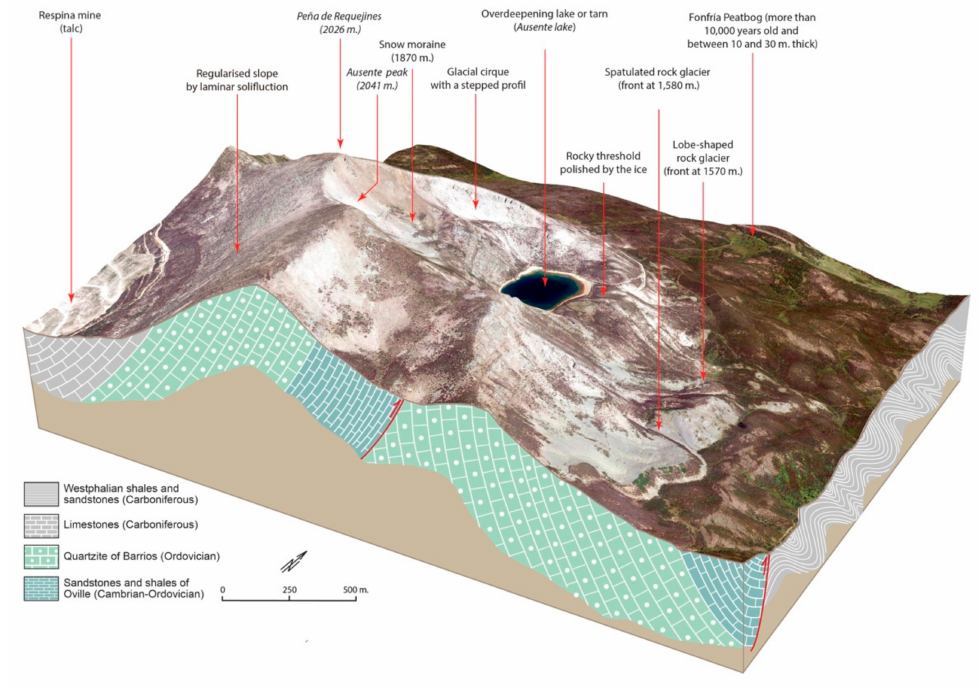
Figure 18. Block-diagram of the Ausente Peak expressing the role of lithology and tectonics in the organisation of the relief. An indication of the main forms is added as complementary